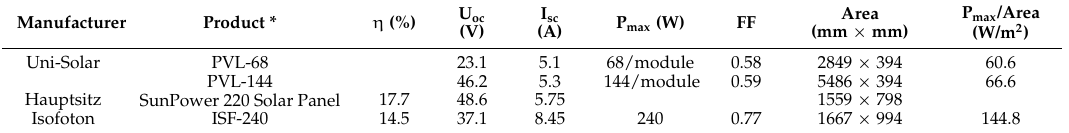
amorphous, polycrystalline or monocrystalline cells with different distances between the cells.